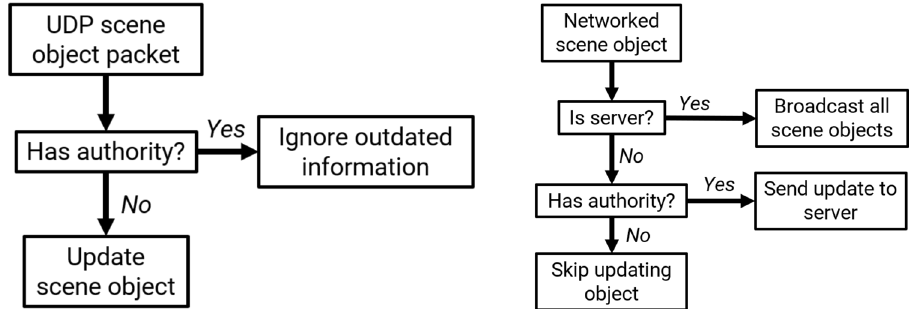
Figure 4. High-level authority model flow chart for a network node for (left) receiving and (right) sending